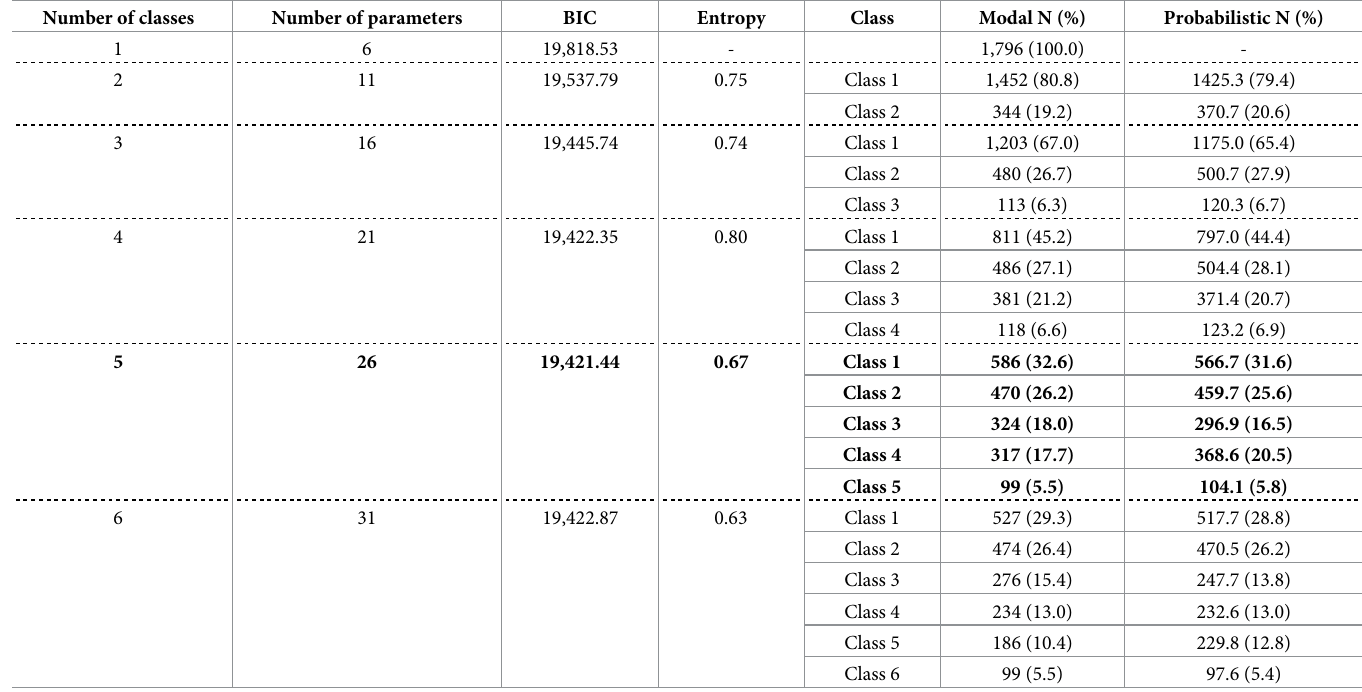
Table 2. Latent class analysis (LCA) model summaries—The preferred model from this step was used in Procedures 2 and